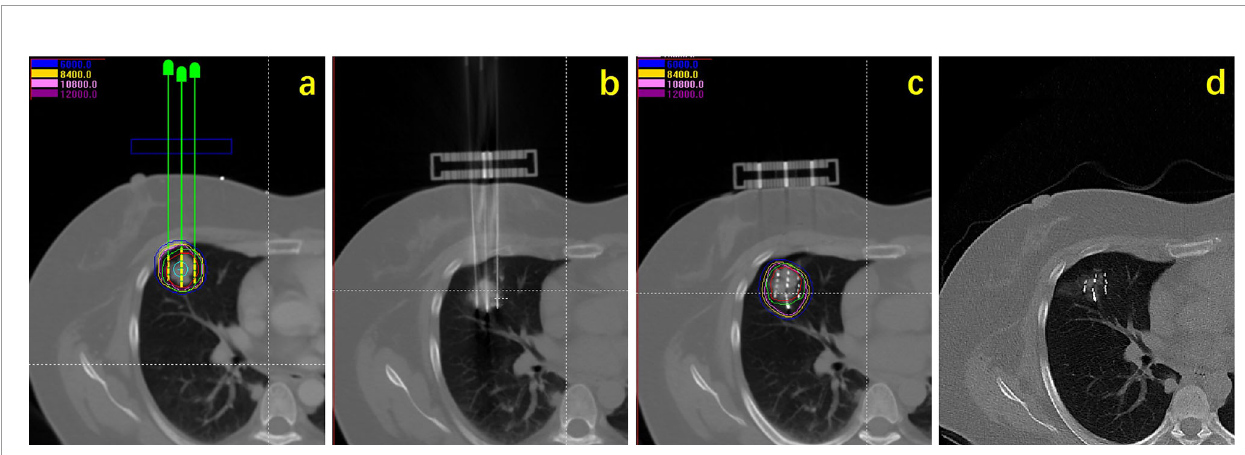
FIGURE 1 | Flow chart showing procedure of seeds implantation: (A) Preoperative planning design; (B) intraoperative needle insertion; (C) seeds implantation and dose veri fi cation; (D) ef fi cacy